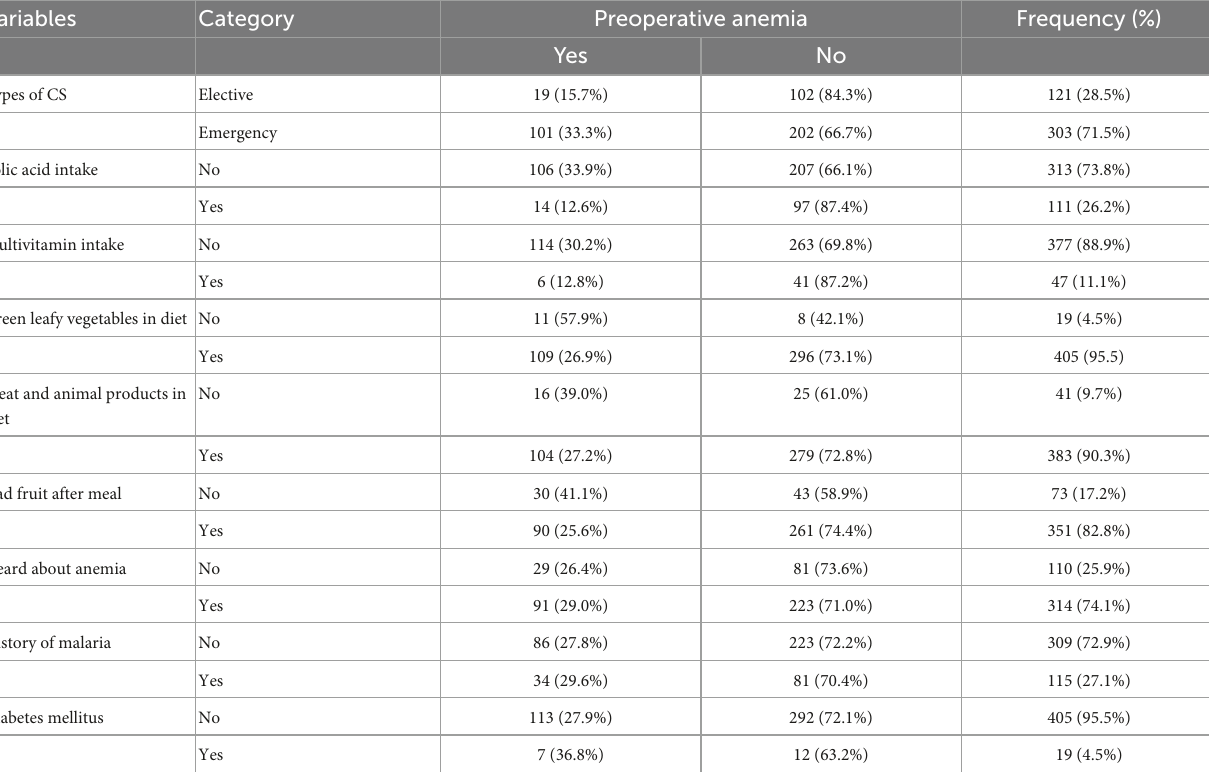
TABLE 2 Clinical and obstetric characteristics of women undergoing cesarean section at University of Gondar comprehensive specialized hospital,